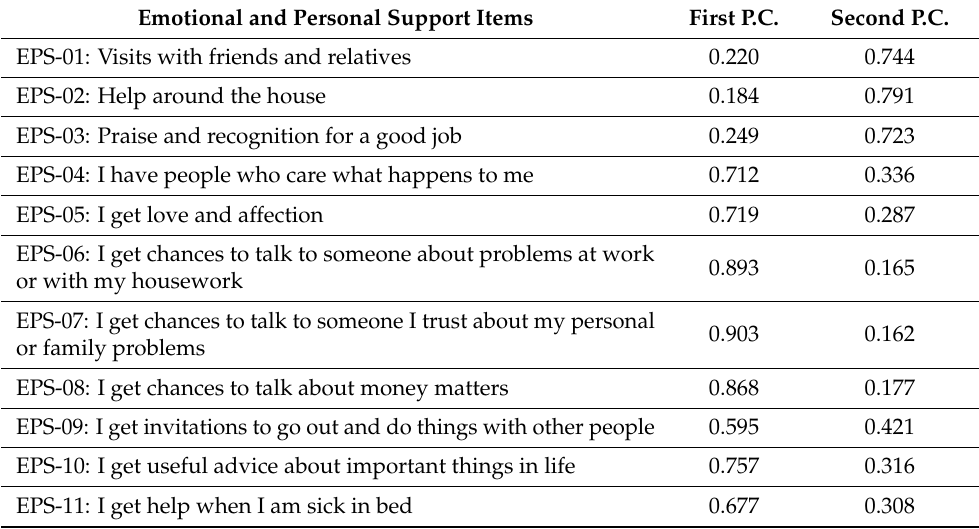
Table 3. Principal components for EPS items.